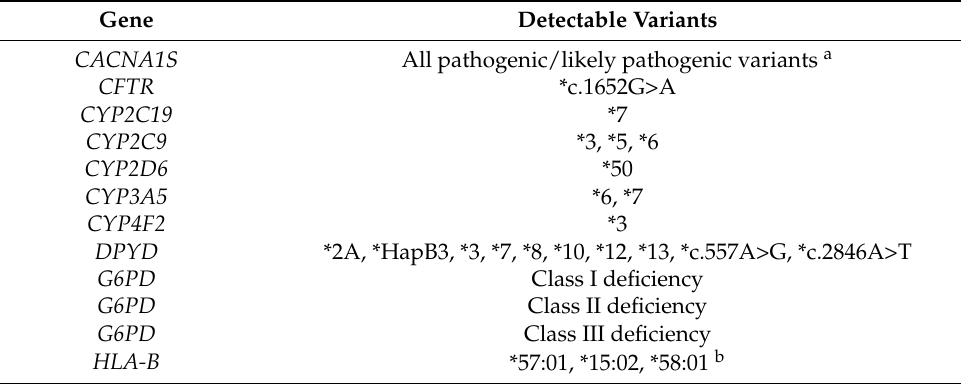
Table A1. Genes and variants detectable from medical-exome